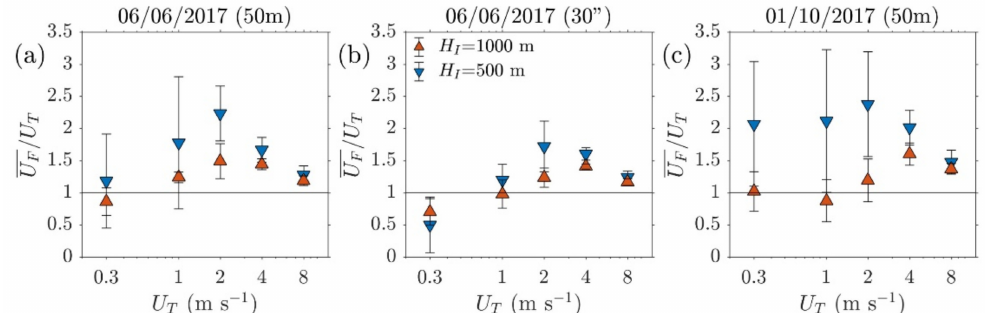
Figure 14. Ratio of average fall speed to particle terminal velocity ( U F / U T ) against U T , averaged for all particles for the: ( a ) June (50 m), ( b ) June (30”), and ( c ) October (50 m) simulations and for two injection heights, H I = 1000 and 500 m agl (red and blue markers, respectively). Standard deviation values are shown using error bars.